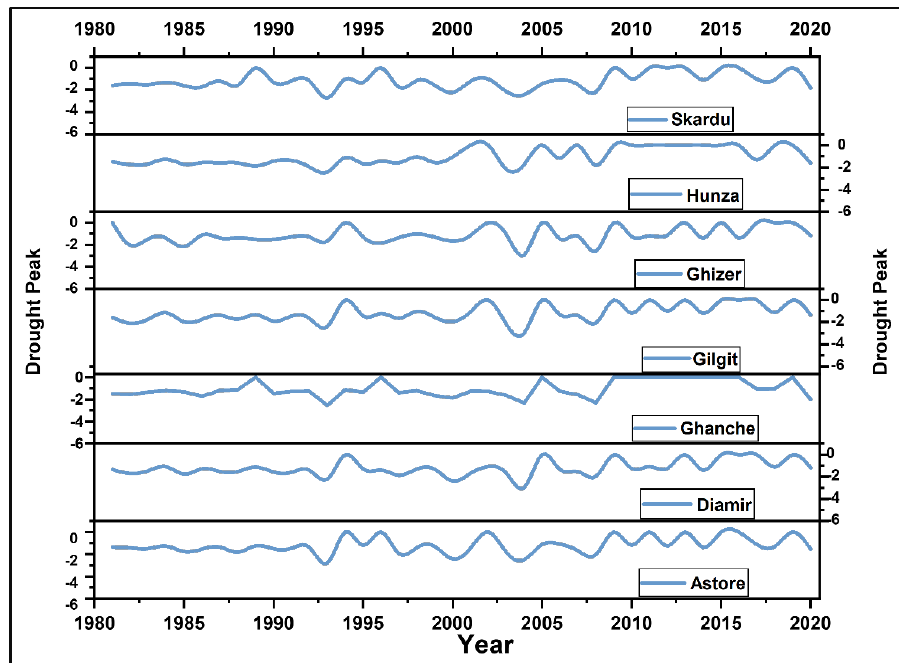
Figure 6. Intensity of drought for all districts.